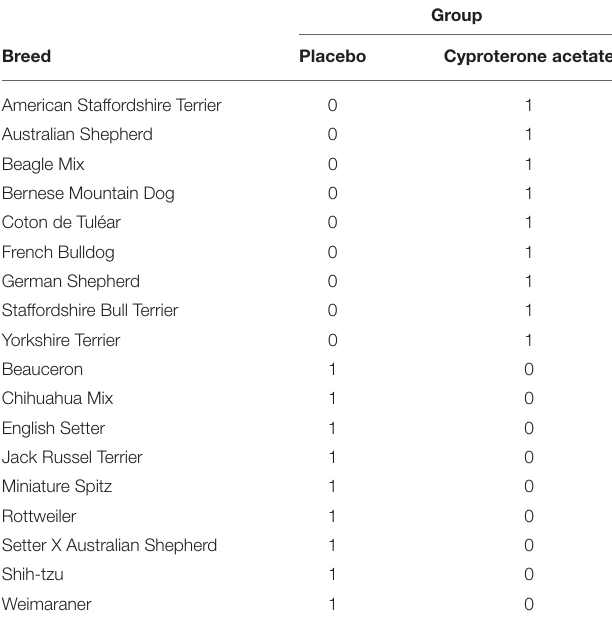
TABLE 2 | Numbers of subjects by breed in the two treatment groups.